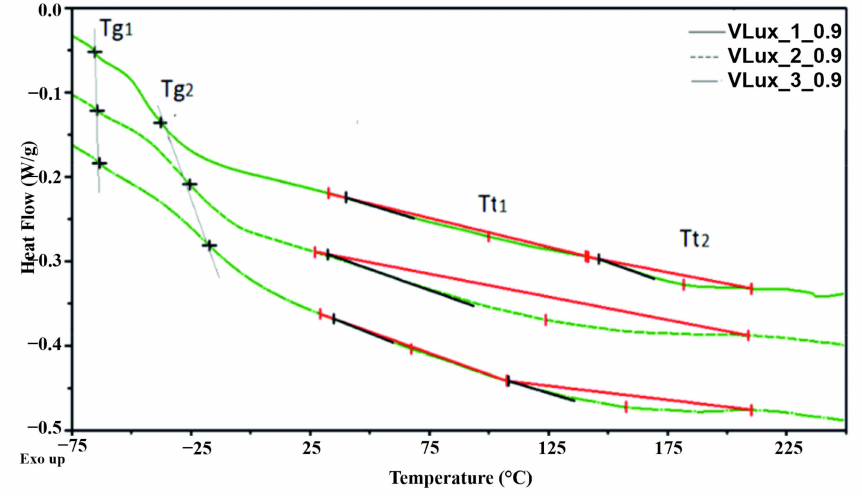
Figure 11. DSC thermograms were obtained in the first heating cycle for foams with different water content and INCO = 0.9.